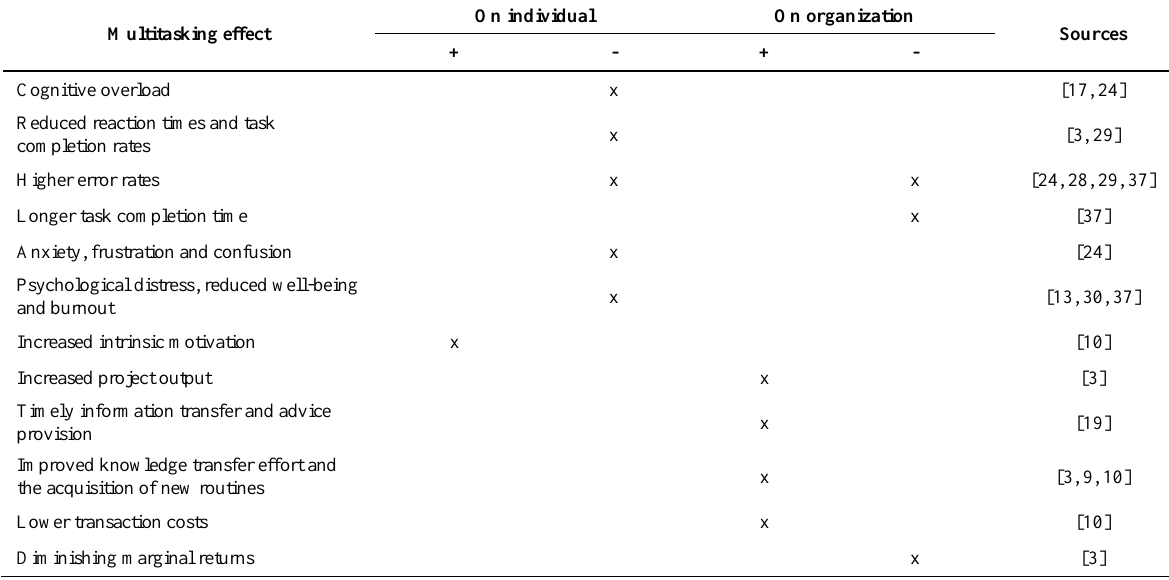
Table 2. Positive and negative effects of